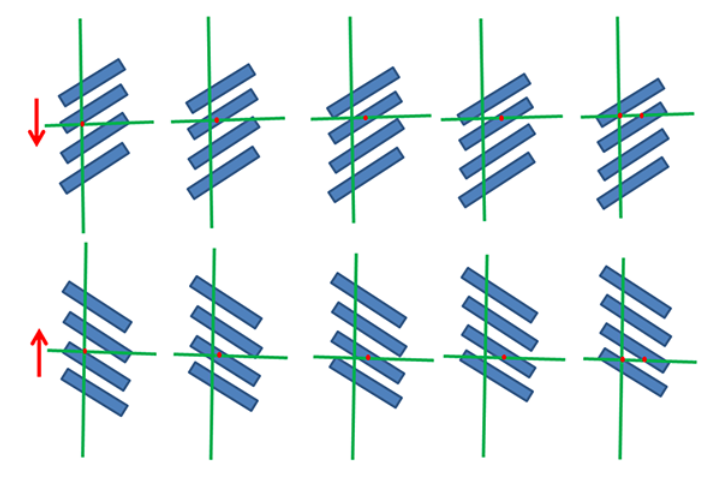
Figure 3 Scheme showing the direction of lateral displacement of the marker (red dot) in the ripple pattern moving downward in the upper panel and upward in the lower one; in both cases the marker shis to the right because of the opposite orientation of ripples in both patterns: Z in the upper panel and S in the lower one.